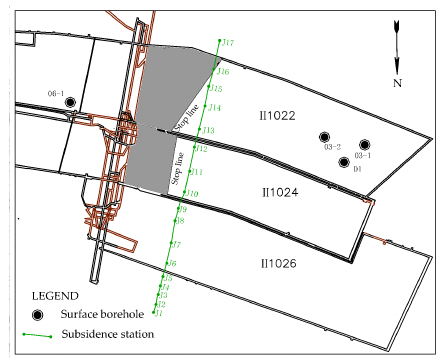
Figure 3. Plan view of the west wing of district No.102.